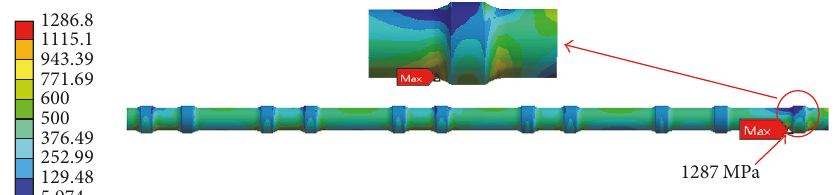
Figure 20: Equivalent stress distribution of the turbine tie rod at time of 600s/MPa.